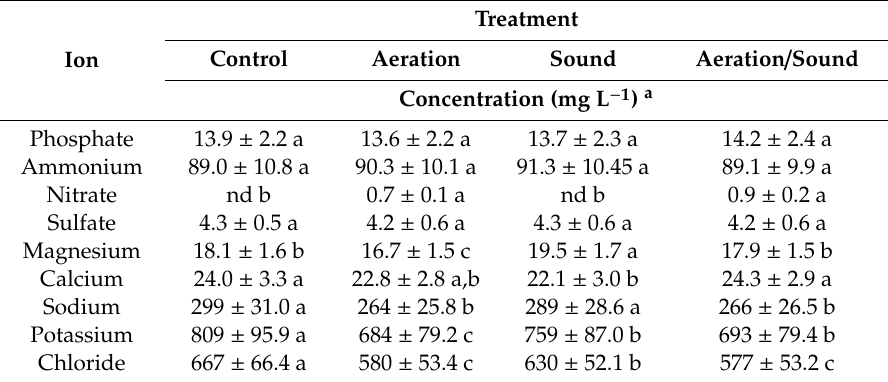
Table 2. Ion chromatographic analysis of poultry litter digestates.